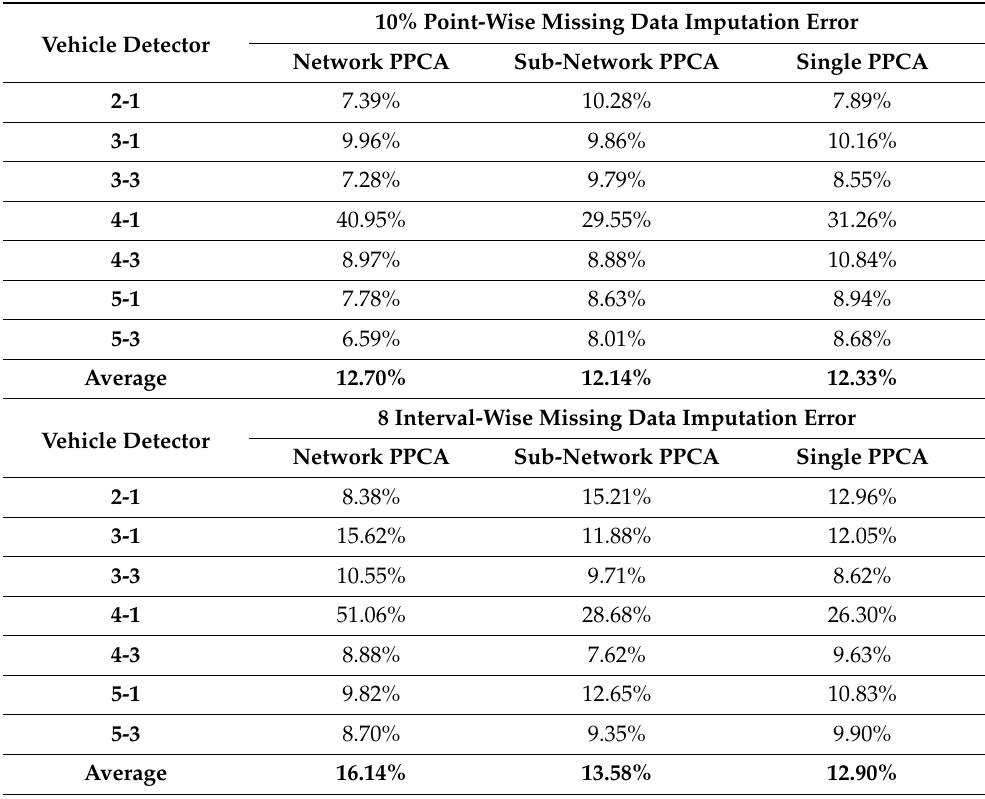
Table 2. Imputation error of each vehicle detector in Diponegoro neighborhood for 10% point-wise missing data and 8 interval-wise missing data. Vehicle Detector 4-1 is considered an outlier, as it has huge imputation error compared to other